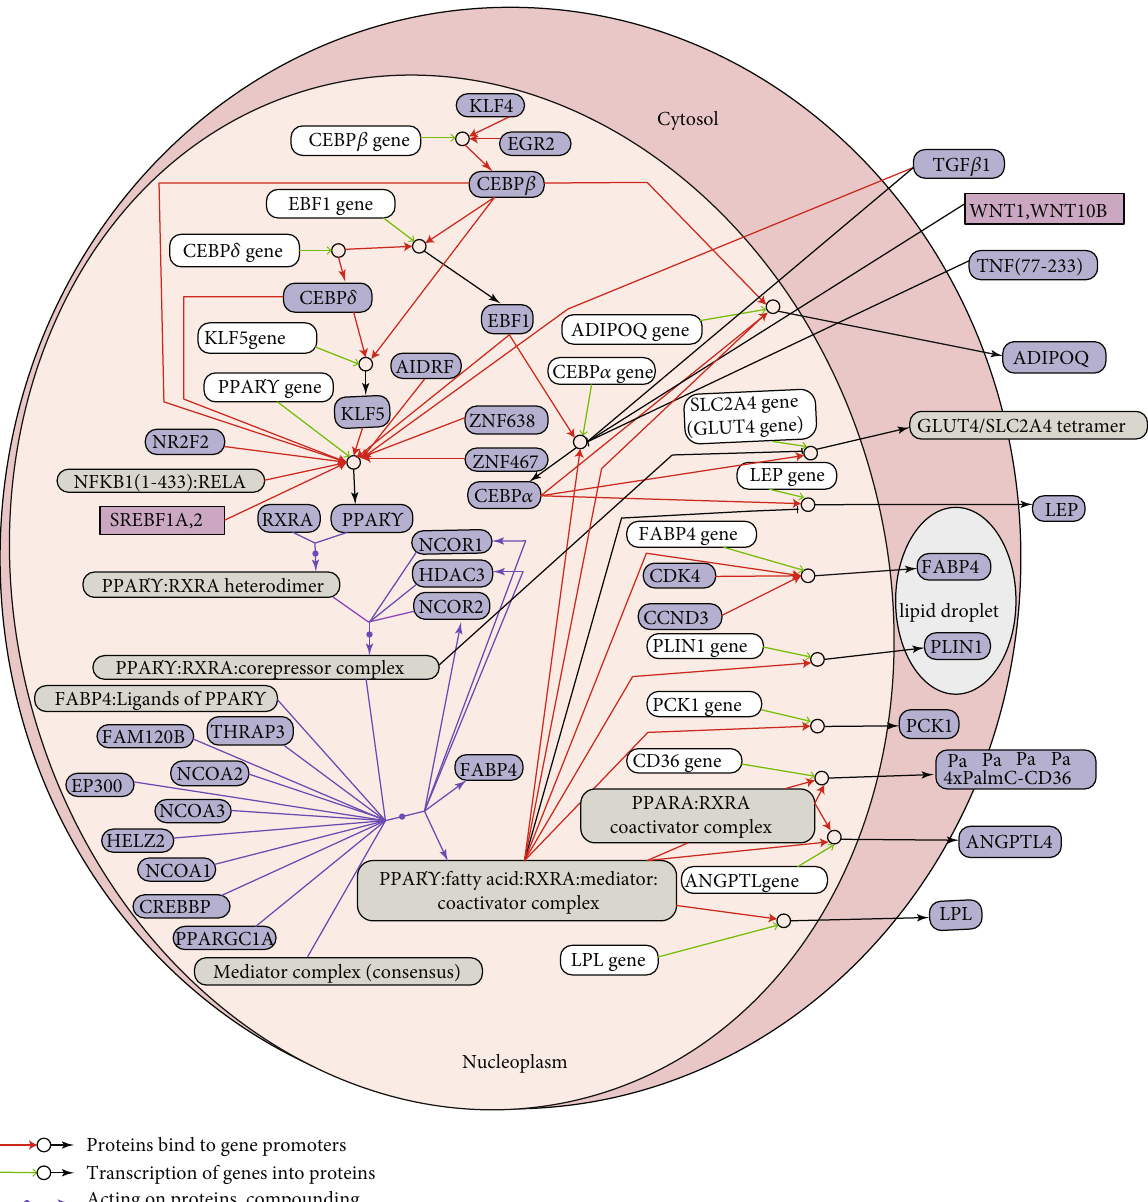
Figure 3: Regulation of adipocyte di ff erentiation. A regulatory loop exists between PPAR γ and CEBP activation. Transcription factor Coe (EBF) activates CEBP α , CEBP α activates EBF1, and EBF1 activates PPAR γ . CEBP β and CEBP δ act directly on the PPAR γ gene by binding its promoter and activating transcription. CEBP α , CEBP β , and CEBP δ can activate the EBF1 gene and KLF5. The EBF1 and KLF5 proteins in turn bind the promoter of PPAR γ , which becomes activated. Other hormones, such as insulin, can a ff ect the expression of PPAR γ and other transcription factors, such as SREBP1c. PPAR γ can form a heterodimer with the RXR α . In the absence of activating ligands, the PPAR γ -RXR α complex recruits transcription repressors, such as nuclear receptor corepressor (NCoR) 2, NCoR1, and HDAC3. Upon binding with activating ligands, PPAR γ causes a rearrangement of adjacent factors. Corepressors such as NCoR2 are lost, and coactivators such as Transcription intermediary factor TIF2, CBP, and p300 are recruited, which can result in the expression of Cyclic AMP-responsive element-binding protein (CREB) followed by PPAR γ . PPAR γ expression initiates the expression of downstream genes, including angiopoietin-related protein PGAR, Perilipin, FABP4, CEBP α , fatty acid transport-related proteins, carbohydrate metabolism- related proteins, and energy homeostasis-related